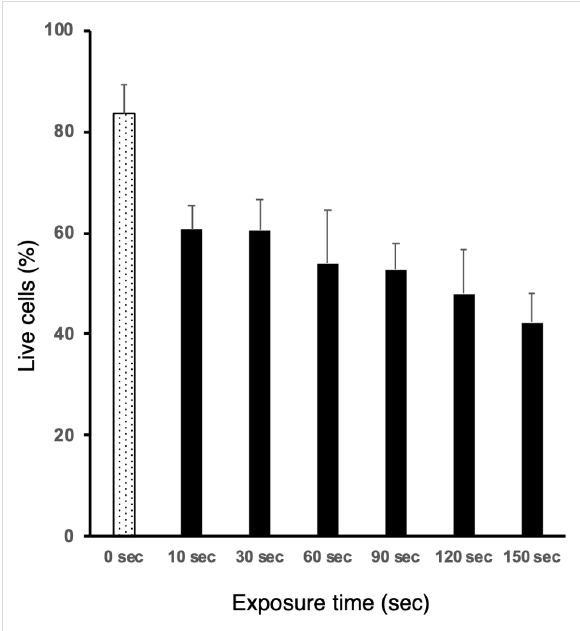
Figure 5: Irradiation time-dependent decline in viability of LLC cells with compound 2a